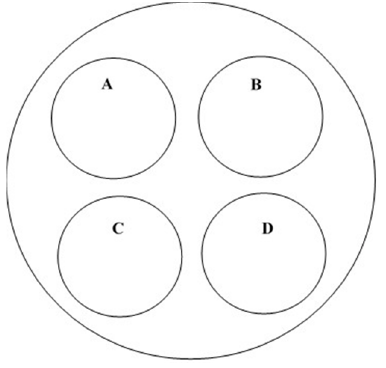
Figure 2. A 150 × 25 mm plastic Petri dish containing four concrete bioassay arenas: ( A ) bioassay arena containing 0.40 ± 0.01 g of T. confusum diet plus 10 adult beetles; ( B ) bioassay arena used for two week residual testing; ( C ) bioassay arena used for four week residual testing; and ( D ) bioassay arena used for six week residual testing.